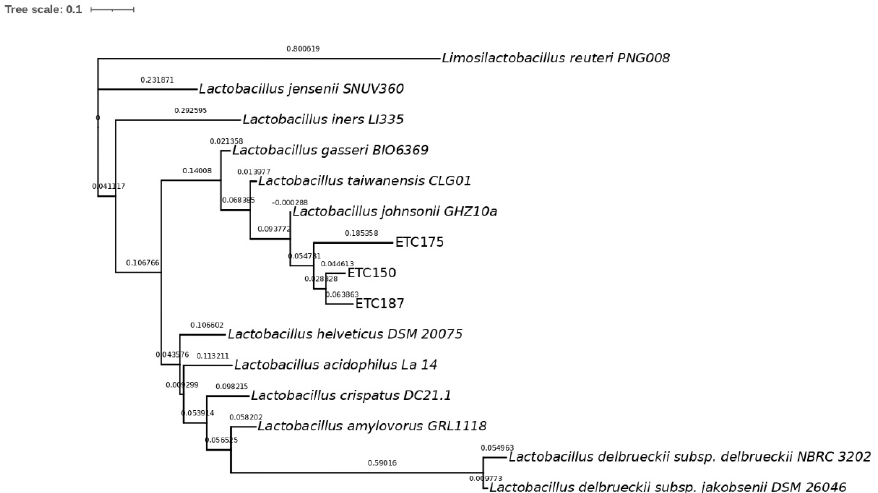
Microorganisms 2022 , 10 , x FOR PEER REVIEW